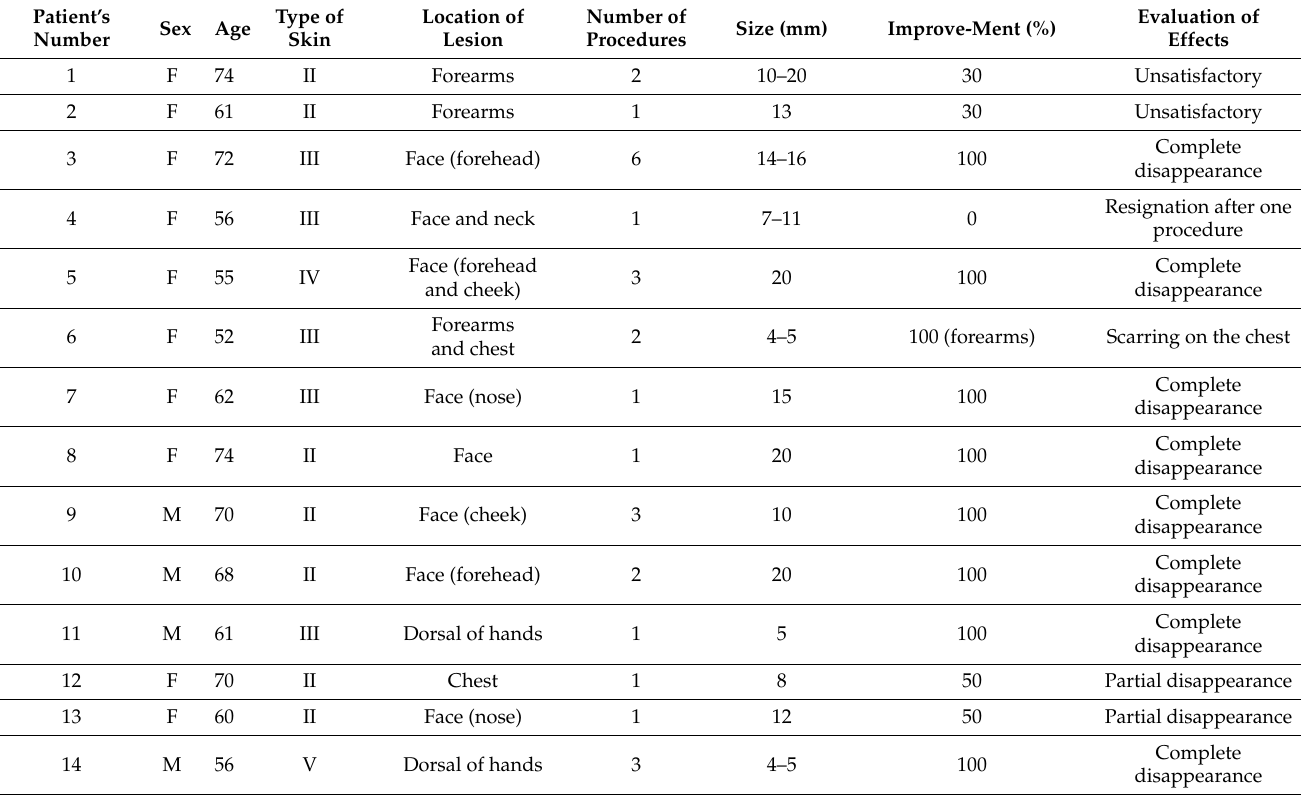
Table 1. Data for the patients with solar lentigines.